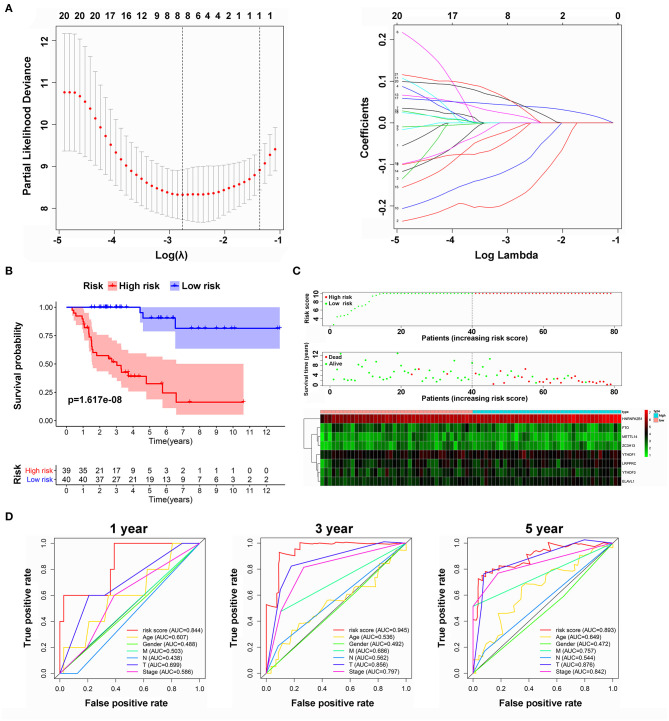
Risk model from m6A-related genes. (A) Lasso Cox regression analysis of 21 m6A-related genes. (B) Overall survival analysis for patients in high/low risk. (C) The distributions of risk scores, alive/dead status, and expression of three m6A-related genes. (D) The ROC curve of risk score and clinical characteristics.